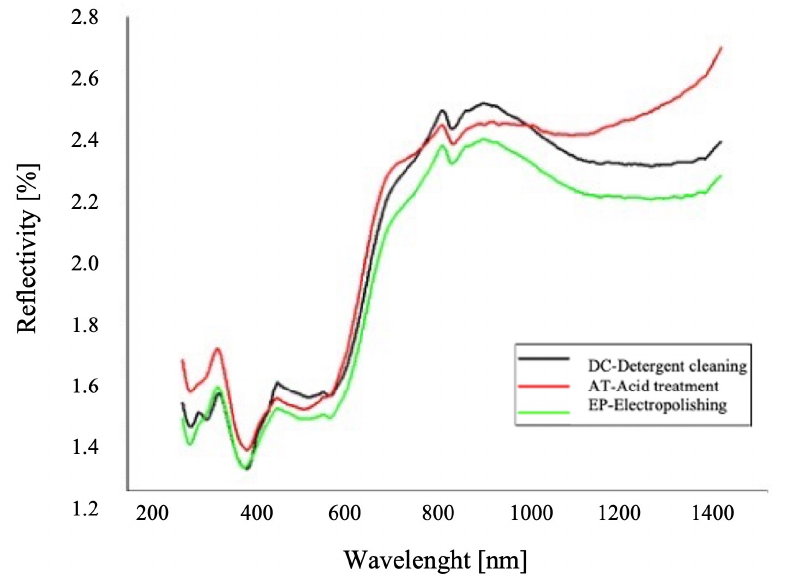
Figure 7. Coatings’ spectral reflectivity according to treatment types (DC-Detergent cleaning, AT- Acid treatment, EP-Electropolishing).